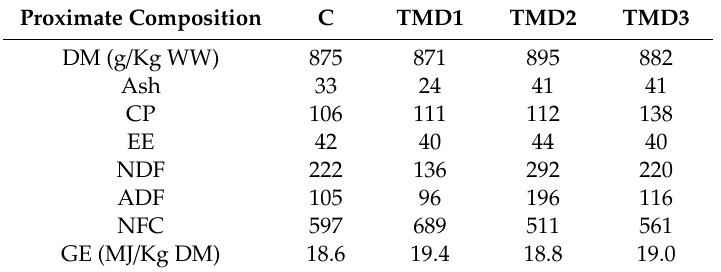
Table 2. Proximate composition (g / kg DM; unless otherwise stated) and gross energy content (MJ / kg DM) of the control (C) and experimental diets (TMD1–TMD3). Proximate Composition C TMD1 TMD2 TMD3 DM (g / Kg WW) 875 871 895 882 Ash 33 CP 106 111 112 138 EE 42 NDF 222 ADF 105 96 NFC